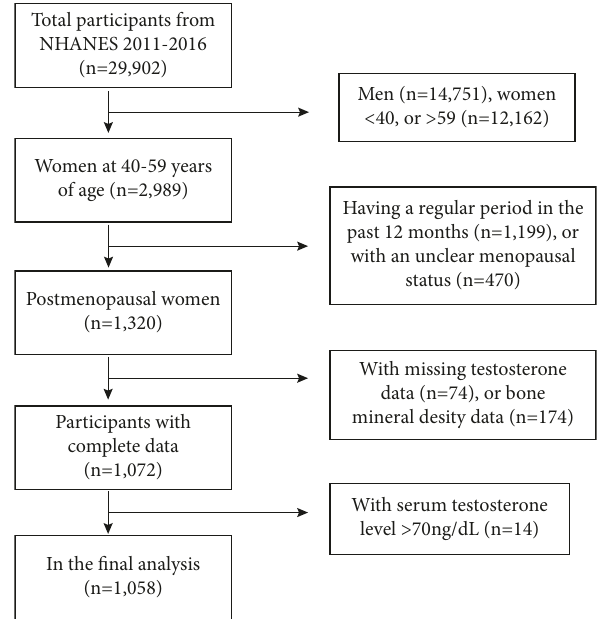
Figure 1: Flowchart of the selection of individuals from the 2011–2016 NHANES